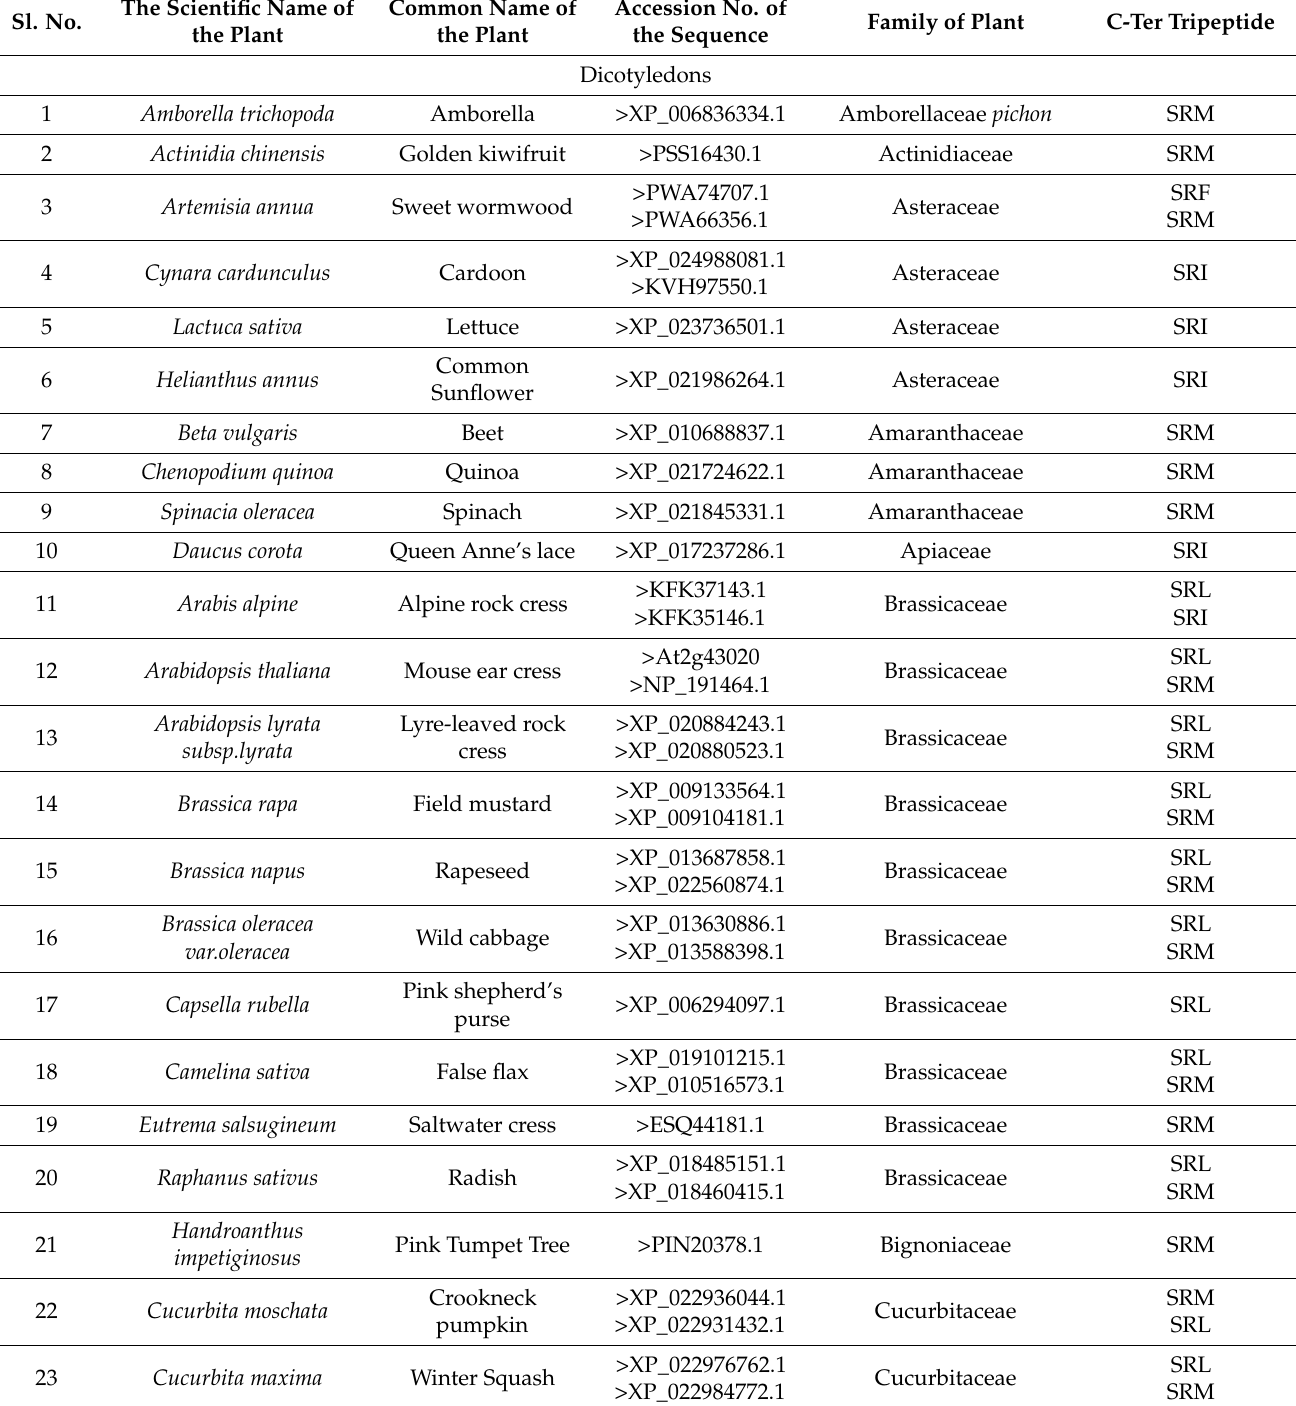
Table 1. The PAO2 from A . thaliana was used as a query sequence in NCBI protein BLAST and 128 dicotyledons, 22 monocotyledons, and 03 lower plants, and probable PAO sequences were obtained. The table contains the scientific names of selected plant species, their common name, family, the accession number of sequences, and the C-terminus tripeptide. Multiple sequences from the same species having the same C-terminus tripeptide have been